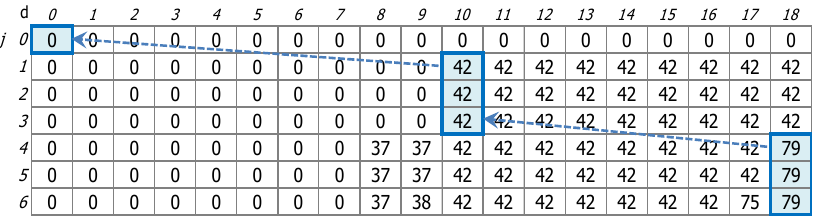
Figure 2. An example of 0/1-KP solving ( n = 6, C = 18) of the basic DP (Algorithm 1): tp -results and soltp = 79 (optimal) in an n x C -matrix and X-tracking for solx = {1, 4}.